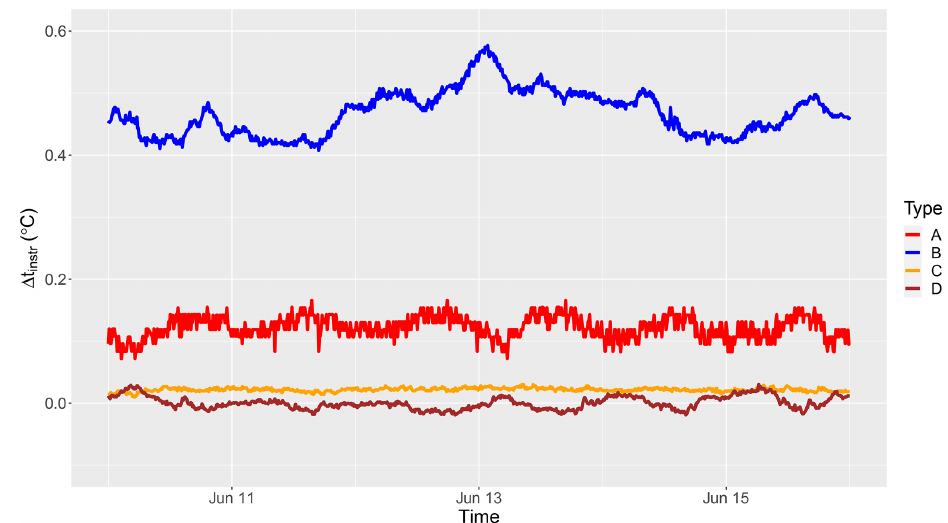
Figure 2. Example of laboratory characterisation. Shown is a 1-week acquisition, at 10min sampling rate, of the differences between the readings of the two sensors of the pair. The E and F systems were not available at the time of the laboratory